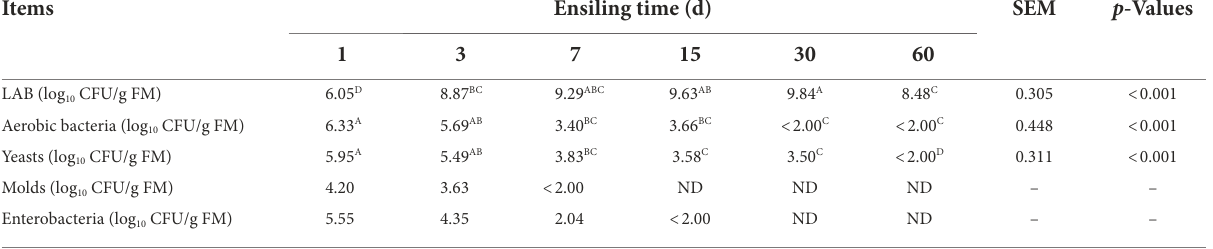
TABLE 3 Changes in the microbial number of SSS. Items